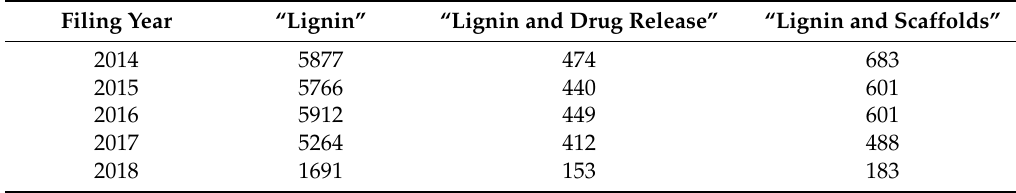
Table 2. Number of patents specifying “lignin”, refined by “lignin in drug release” and “lignin scaffolds”, respectively, according to World Intellectual Property Organization (WIPO), searched